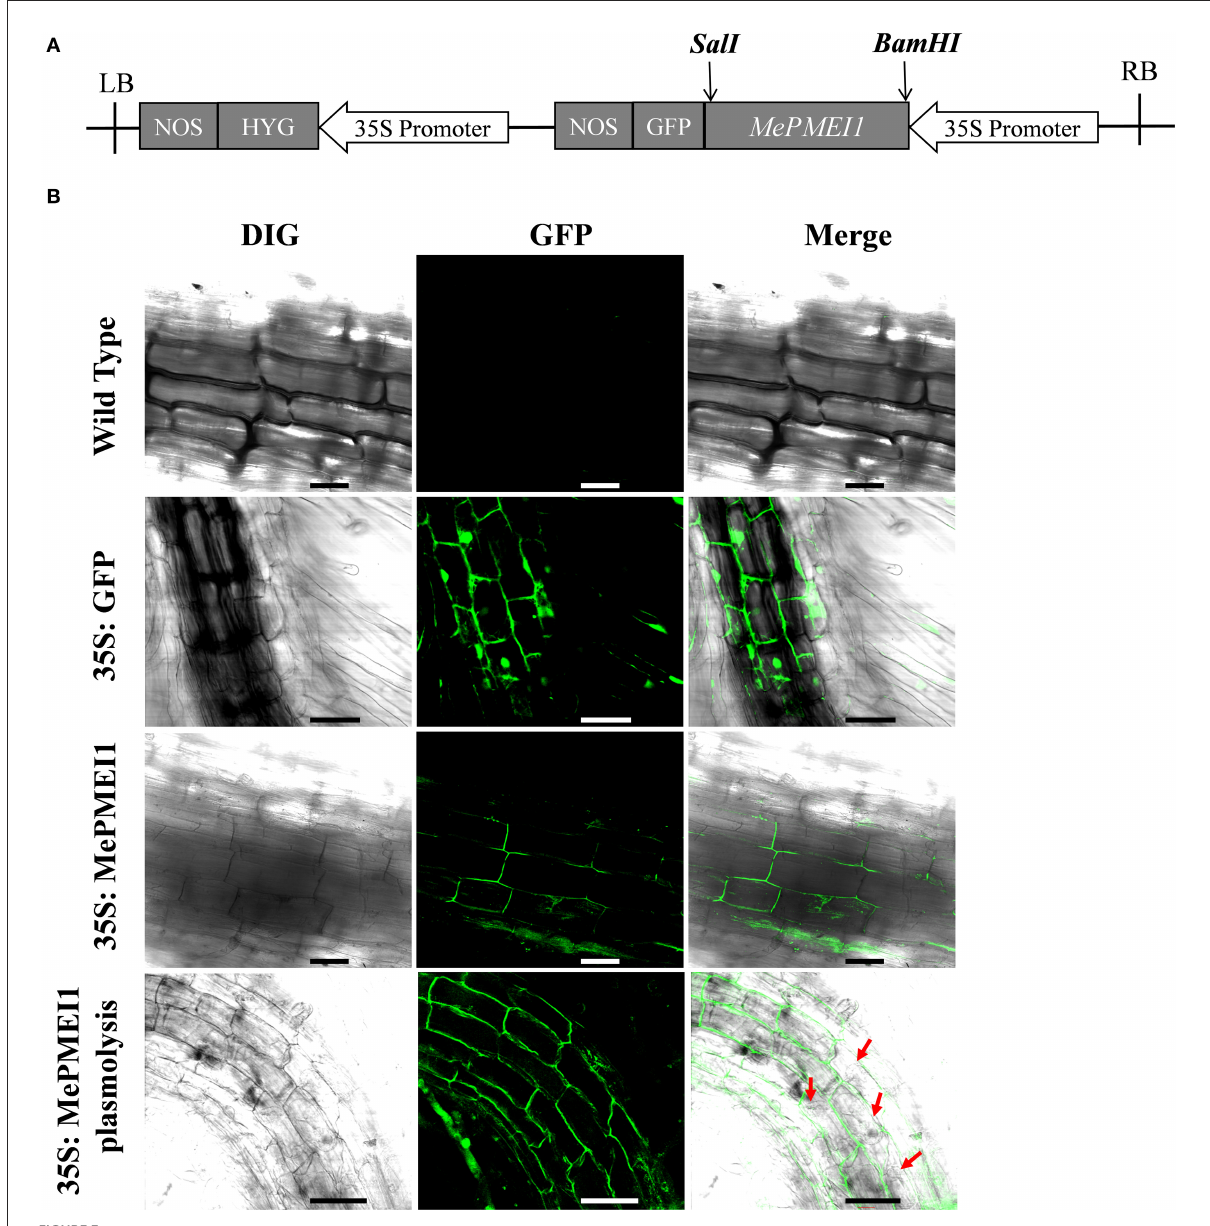
FIGURE3 Analysis of the subcellular localization of MePMEI1. (A) A schematic diagram of the pCAMBIA1300-35s- MePMEI1 -GFP recombinant vector. (B) Analysis of the localization of the MePMEI1 protein in the root tip cells of transgenic tobacco plants by observing the fluorescence signals. The red arrows indicate plasmolyzed cells. Scale bar = 60 µ